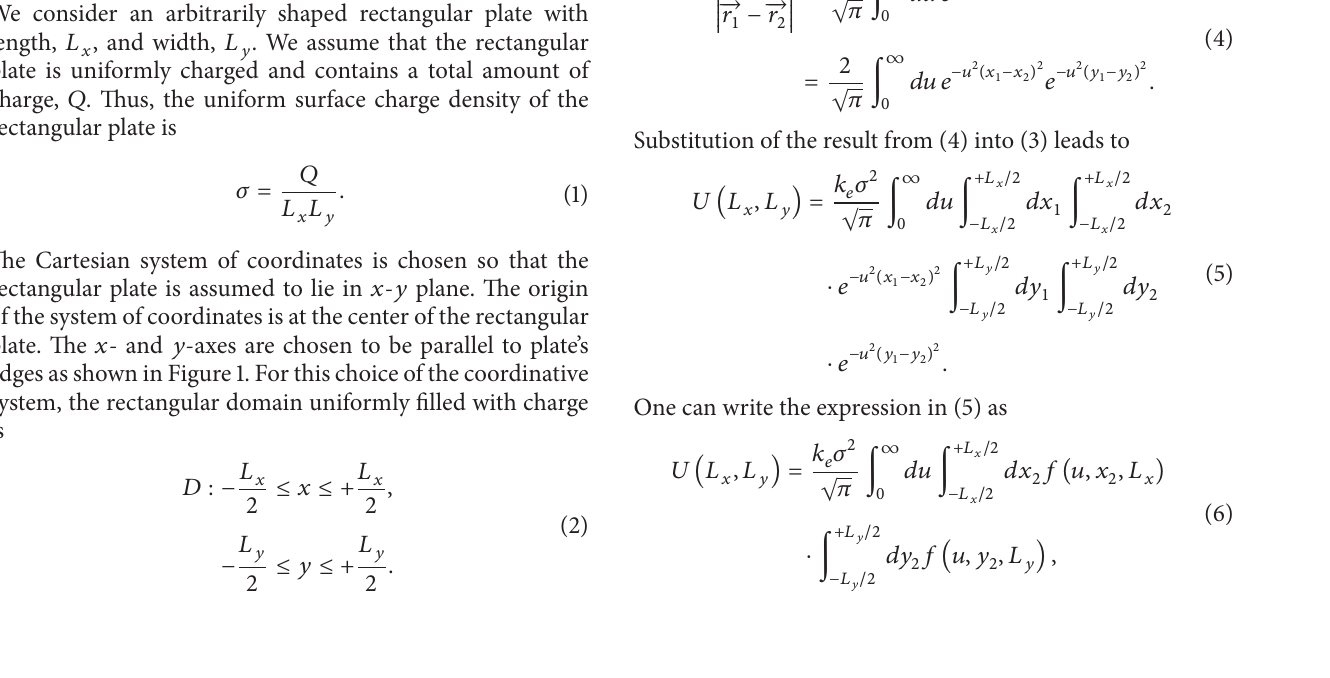
We assume Coulomb interaction between elementary charges = 𝜎𝑑 2 𝑟 𝑑𝑞 1